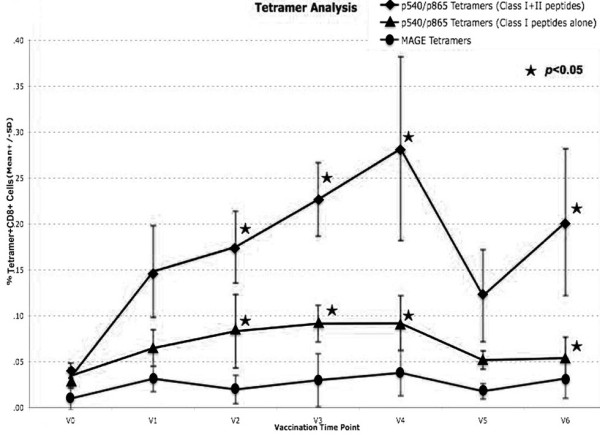
Tetramer+ CD8+T cell responses (mean +/- SD) to class I ± II hTERT pulsed DCs. Vaccinations with DCTs pulsed with class I hTERT epitope alone compared with or without class II epitopes in 6 patients. DCTs pulsed with class I+II epitopes showed a strong tendency to enhance tetramer+CD8+T cell responses which were significant (p < 0.05, t-test) at specific vaccination time points V2, V3, V4 and V6 (ie 4 out of the 6 post-vaccination time points). CD8+T cell tetramer+ response to an irrelevant HLA*A201 MAGE antigen, not used in the vaccination, was measured as a negative control; 150,000 events were acquired and analysed.